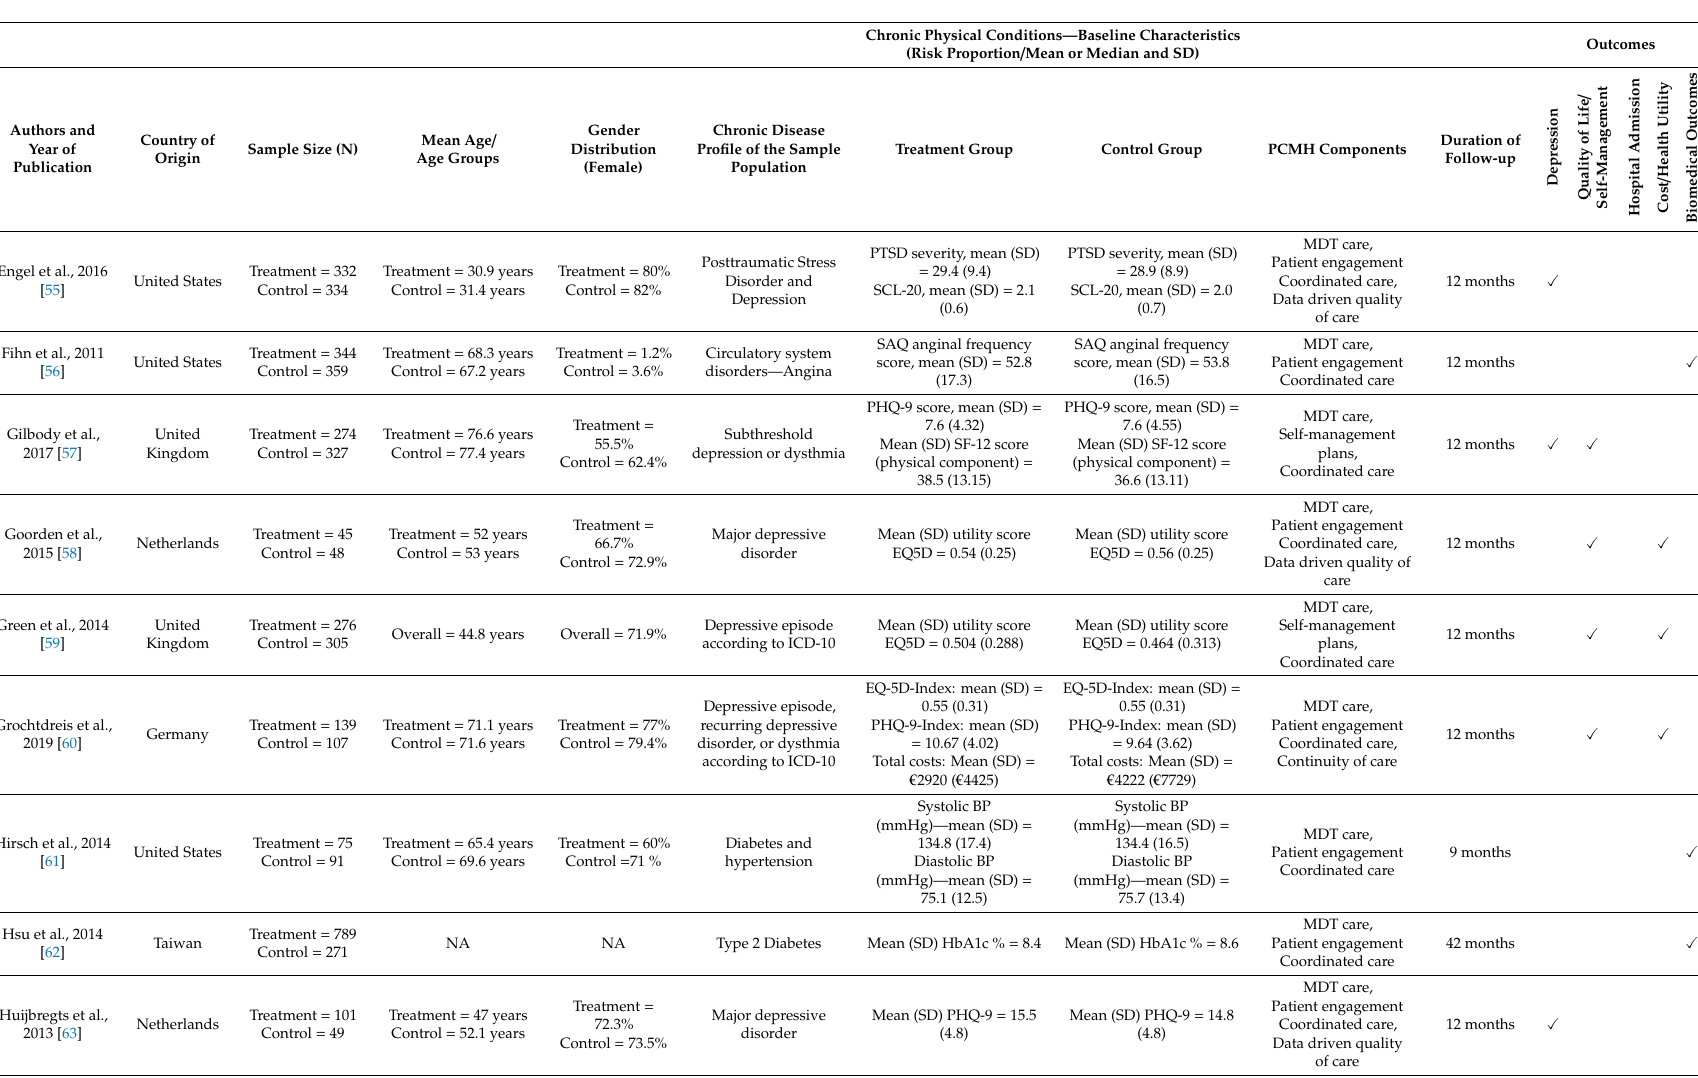
Table A3. Cont. Chronic Physical Conditions—Baseline Characteristics (Risk Proportion / Mean or Median and SD)